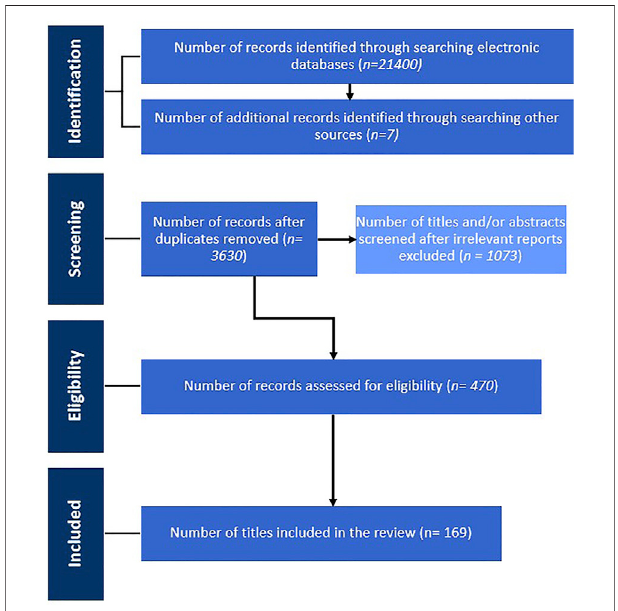
FIGURE6| PRISMA fl owchartdemonstratingtheselectionprocessand criteria.